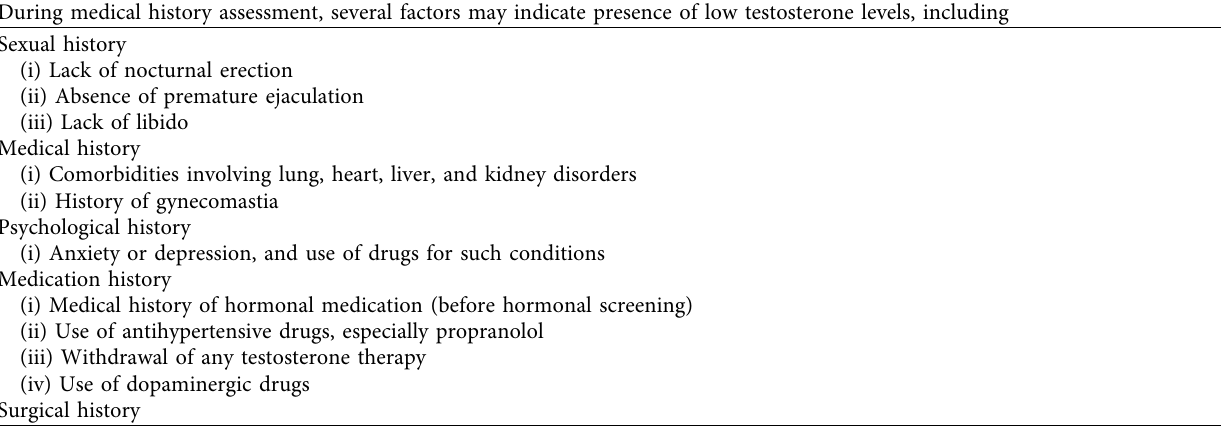
Table 2: Expert opinion on medical history